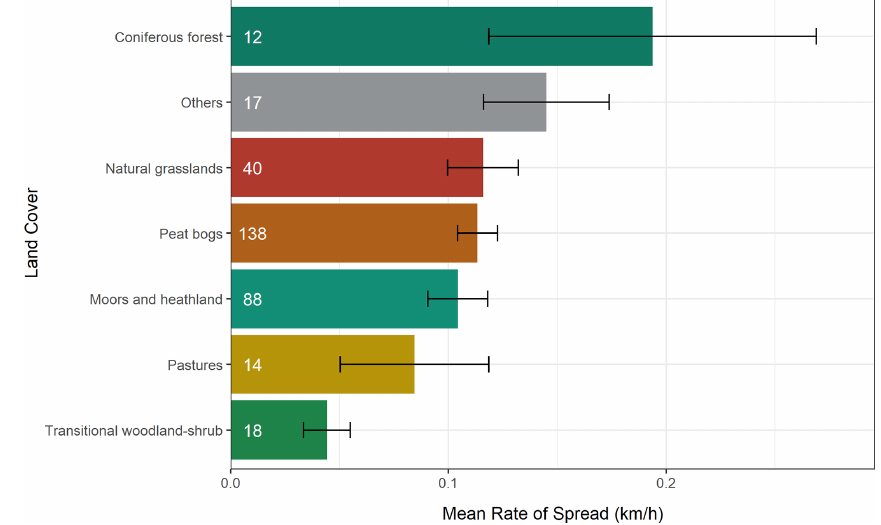
Figure 5. Mean rate of spread and standard error across various represented land cover types in northwest Europe. The category “others” includes other land cover types with low representation (fewer than 10 maximum spread vectors by category). The number of ROS vectors for each land cover type is shown in the chart.